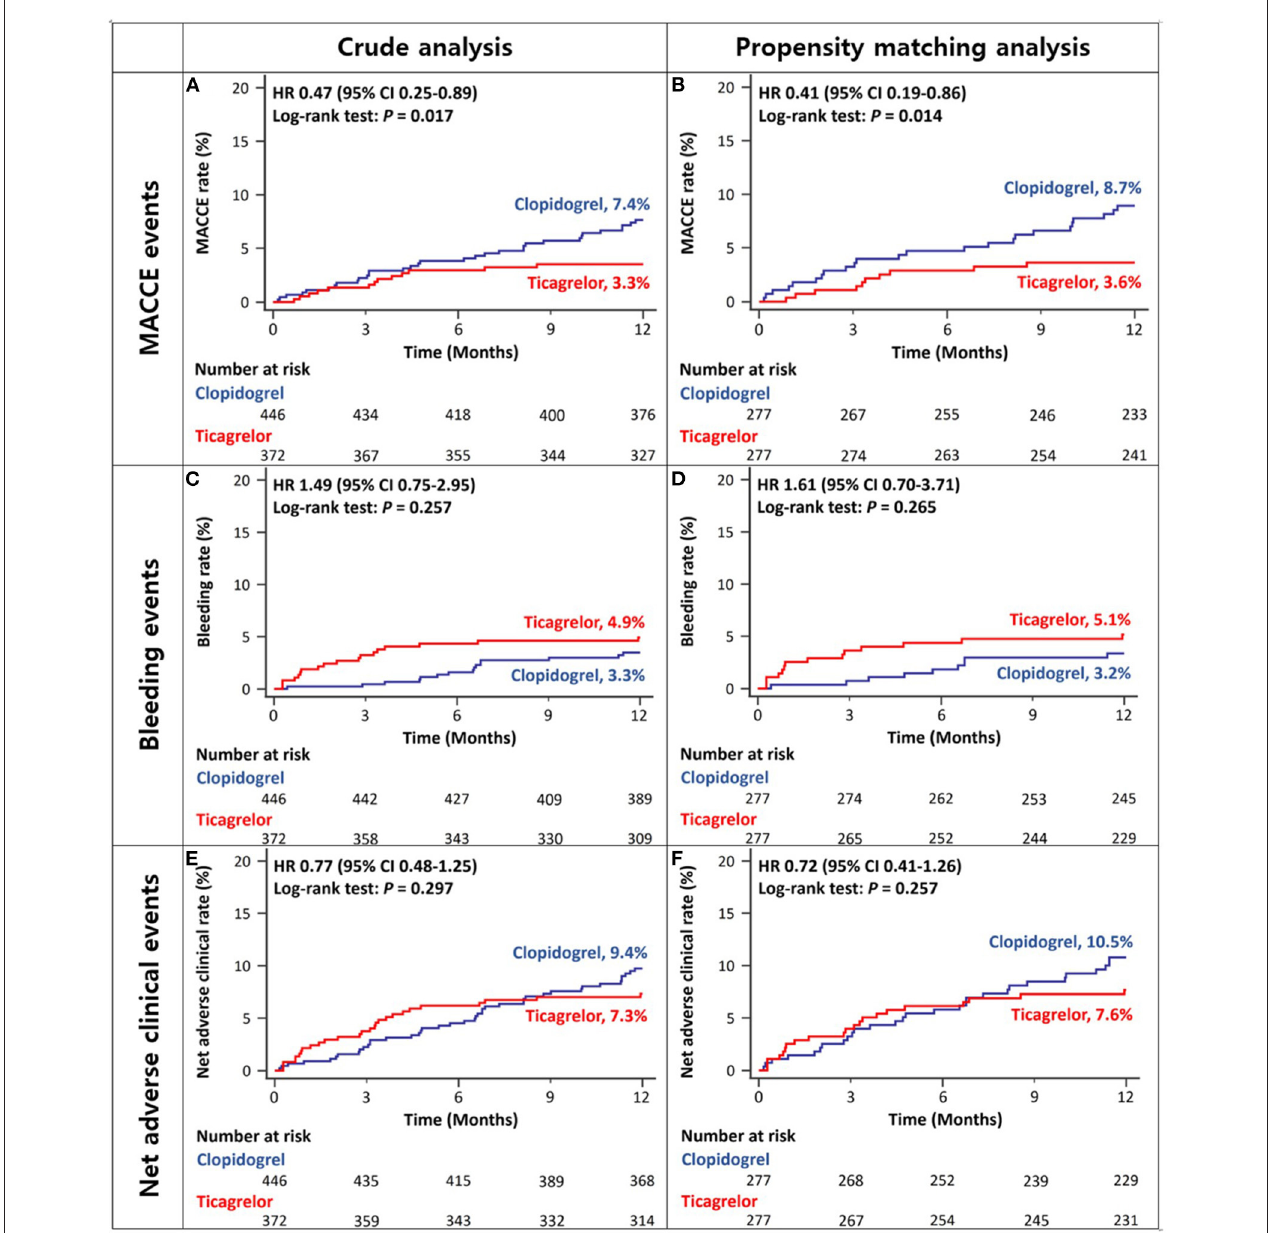
FIGURE 4 | Twelve-month cumulative incidence of major adverse cardiac and cerebrovascular events (A,B) , bleeding (C,D) , or net adverse clinical (E,F) events in patients with CKD stage III/IV without ESRD in crude (A,C,E) and propensity-score matched analyses (B,D,F) . MACCE, Major Adverse Cardiac and Cerebrovascular Event; CKD, Chronic Kidney Disease; ESRD, End Stage Renal